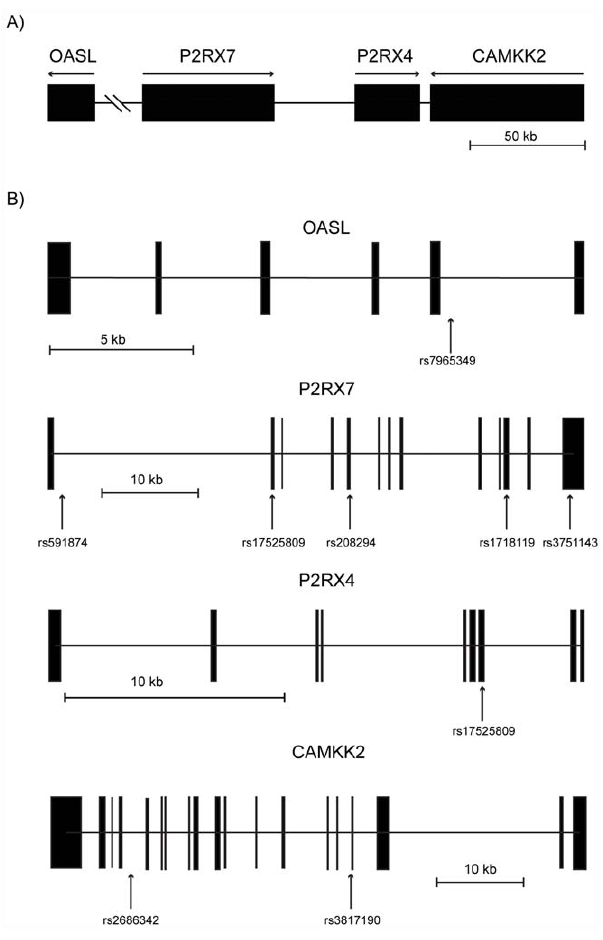
Figure 1. Schematic map of the genomic region containing OASL , P2RX7 , P2RX4 and CAMKK2 . A) Filled boxes represent genes. Arrows indicate transcriptional direction. B) Filled boxes indicate exonic regions. The position of each SNP included in the study is indicated by vertical arrows.